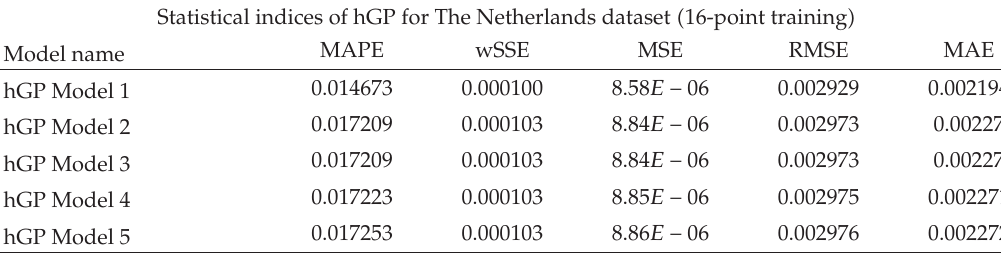
Table 17: Statistical indices of the first five produced hGP models for The Netherlands (cid:2) forecast period—2 years (cid:3) .